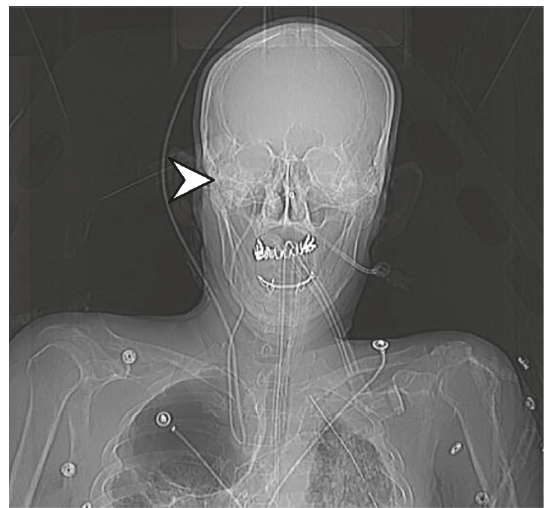
Figure 2: CT Venogram of the head with arrow depicting mispo- sitioned tip of the venous catheter within the right internal jugular vein at the level of the jugular